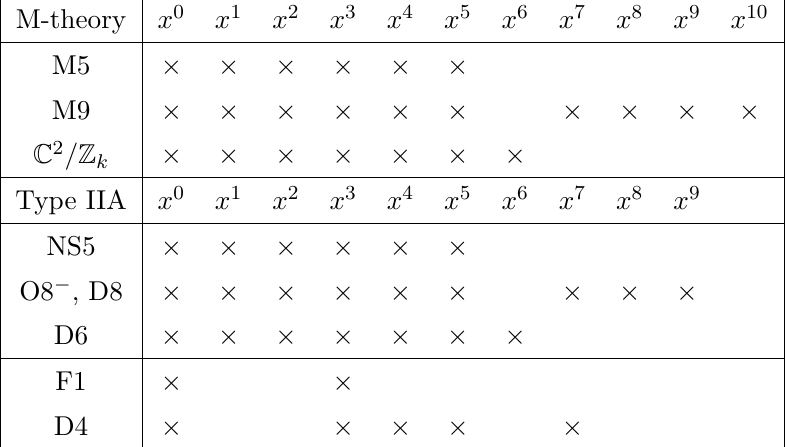
Table 1 . Upper part: occupation of space-time directions by M5, M9, and A k (cid:0) 1 singularity in M-theory. Lower part: occupation of space-time directions by NS5, O8 (cid:0) , D8, and D6 in Type IIA. The fundamental string F1 and the D4 branes are virtual objects which are used to read o(cid:11) the electric and magnetic